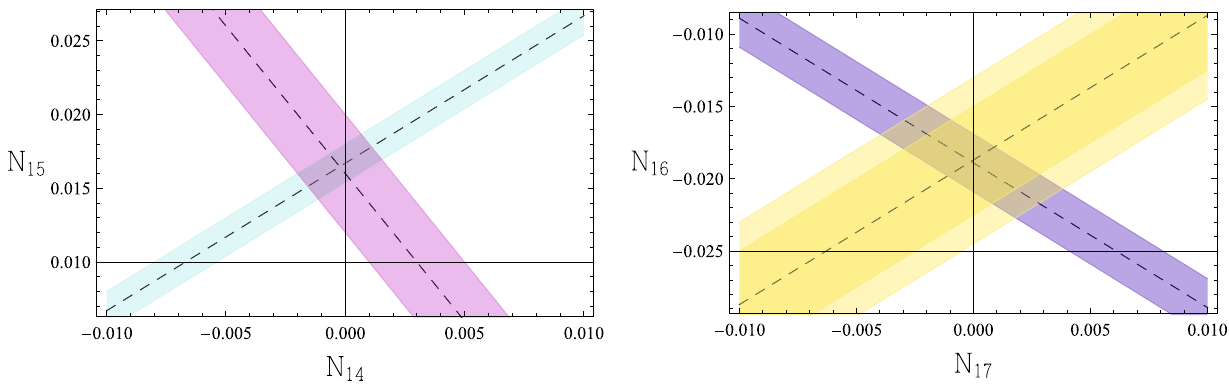
Fig. 4 Left panel: values of N 14 and N 15 as given by K ± → π ± γ ∗ (blue band) and K S → π 0 γ ∗ (violet band). Right panel: values for N 16 and N 17 extracted from K ± → π ± π 0 γ (blue band) and K ± → π ± π 0 e + e − (yellow band) measurements. The latter is an educated estimate (see main